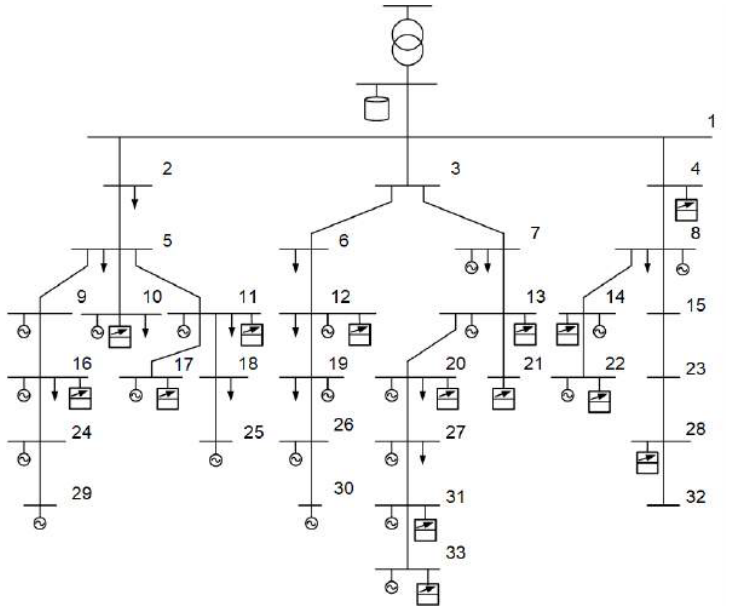
Figure A1. Cluster 02. Single-line diagram for the baseline. Table A3. Cluster 02. LV network characterization, installed capacity of loads, generators, and HEMS for the